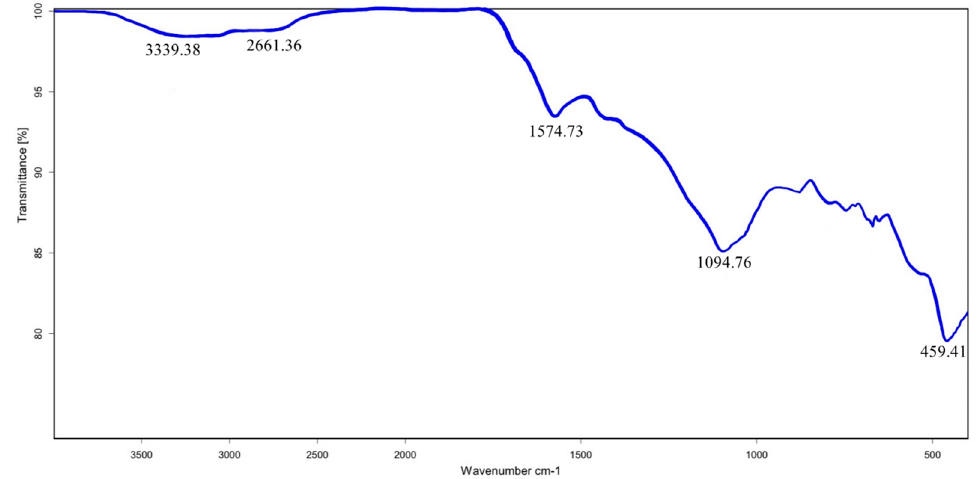
Figure 5. Transmittance spectrum of rice husk biochar obtained with Fourier-transform infrared (FTIR) spectroscopy.